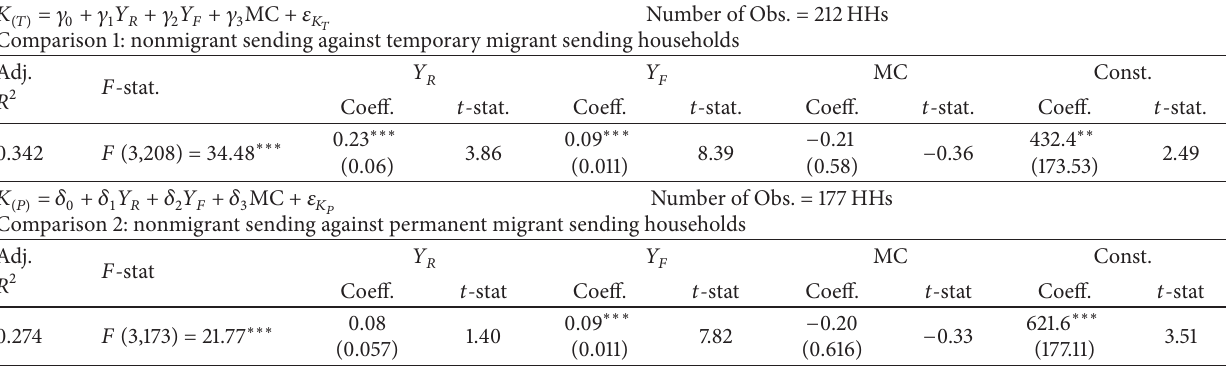
Table 2: Stage 1 estimation result for the determinants of capital